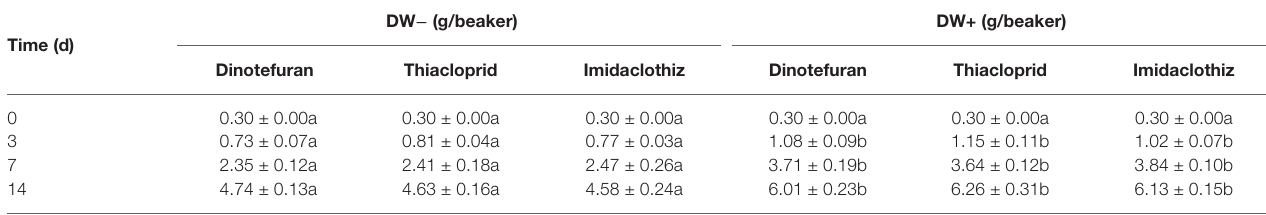
Treatments: DW − , uninoculated duckweed; DW+, duckweed inoculated with FC02. Values are mean ± standard deviations (n = 3). Different letters indicate significant differences (p < 0.05; Tukey’s test) among treatments.